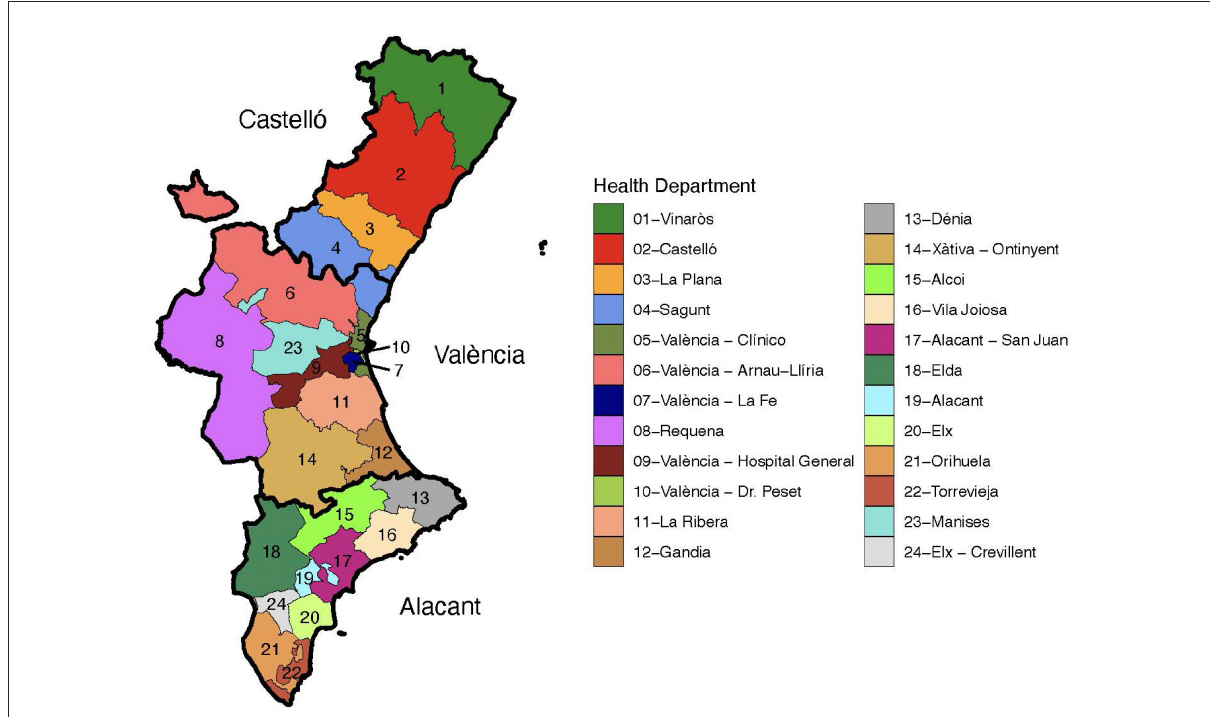
FIGURE1 Health departments in the Valencian Region of Spain. Each province is depicted with a thicker contour and